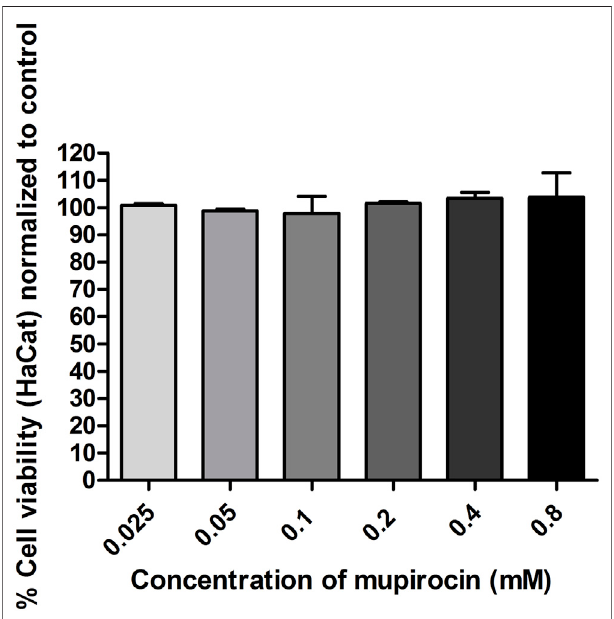
FIGURE 2 | Percentage normalized cell viability of human keratinocytes (HaCat) treated with mupirocin, at concentrations ranging between 2.5 × 10 − 2 − 0.8 mM, after 72 h. Data is presented as mean ± SEM of two independent experiments conducted in triplicate.